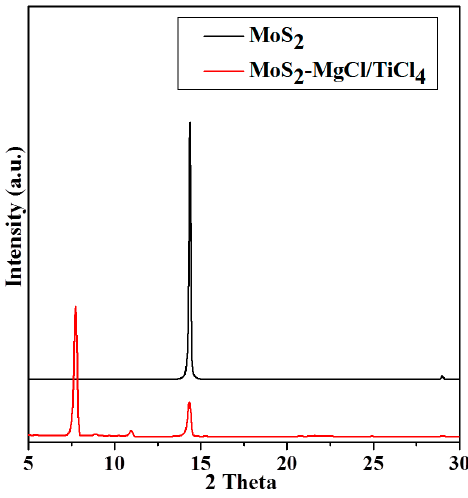
Figure 2. XRD patterns of MoS 2 and MoS 2 -MgCl-supported Ziegler–Natta catalyst.